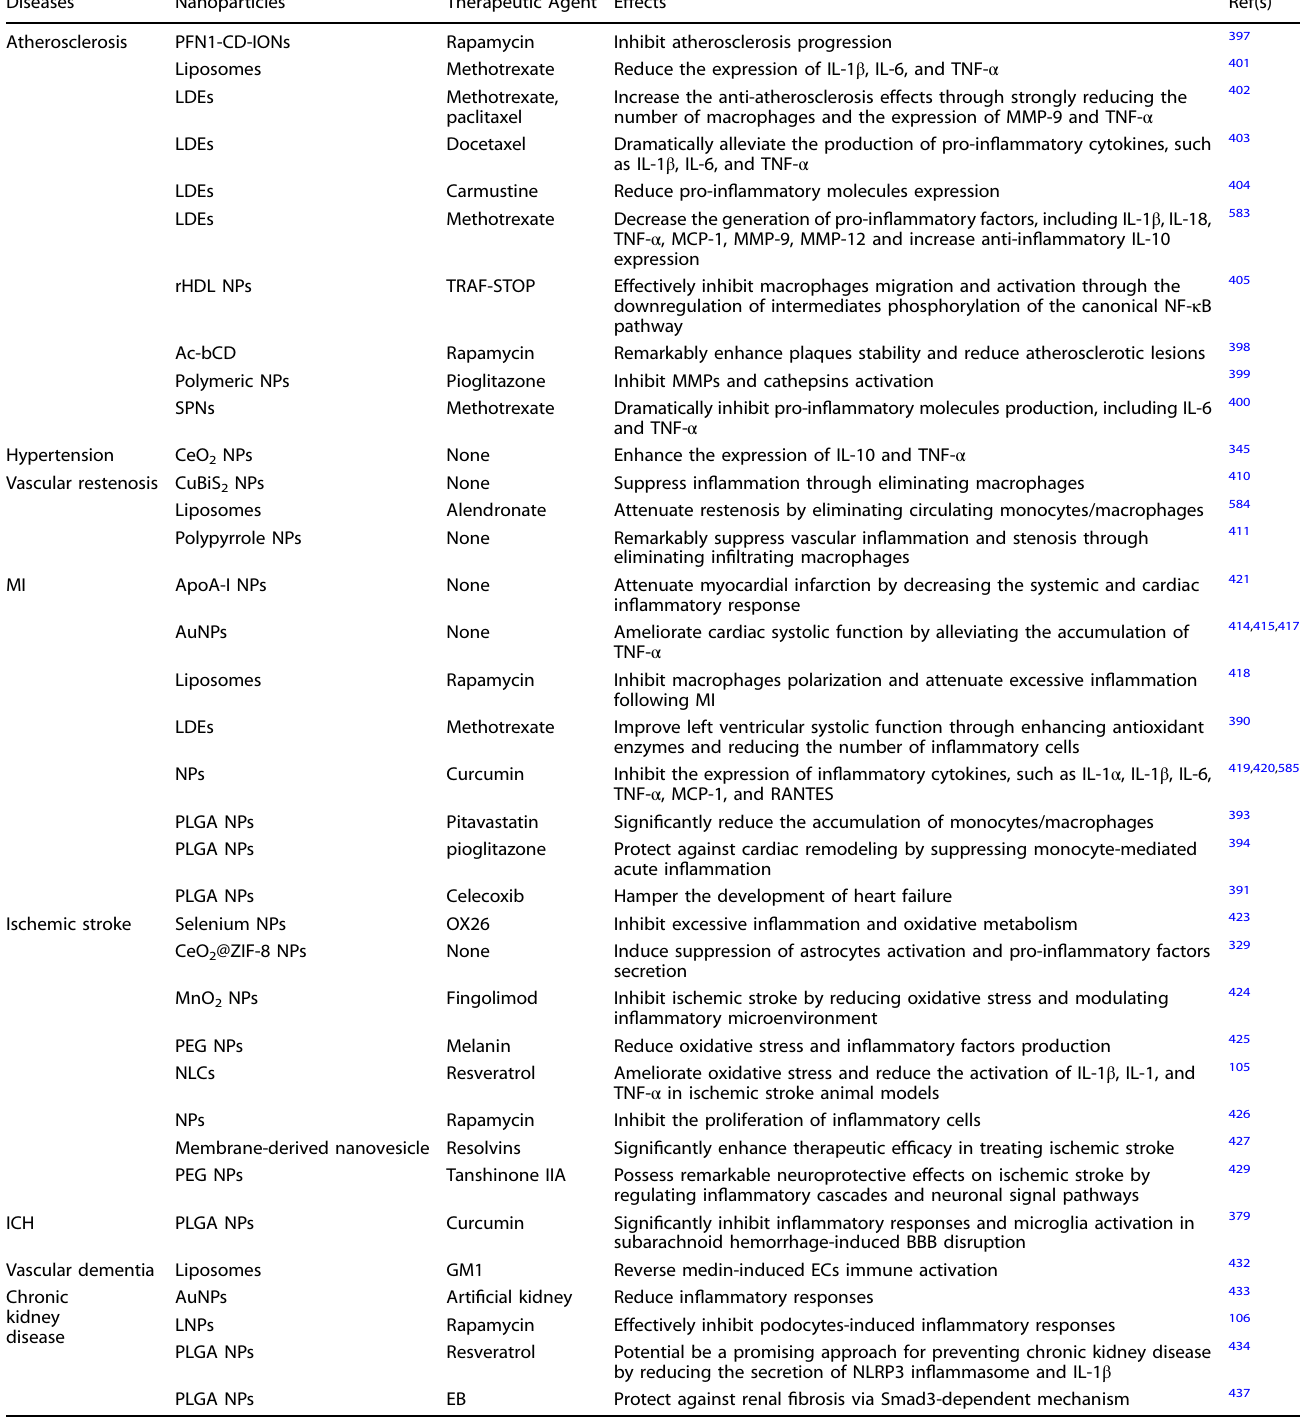
Table 4. Nanoparticles-mediated anti-in fl ammatory therapies for vascular aging-related diseases